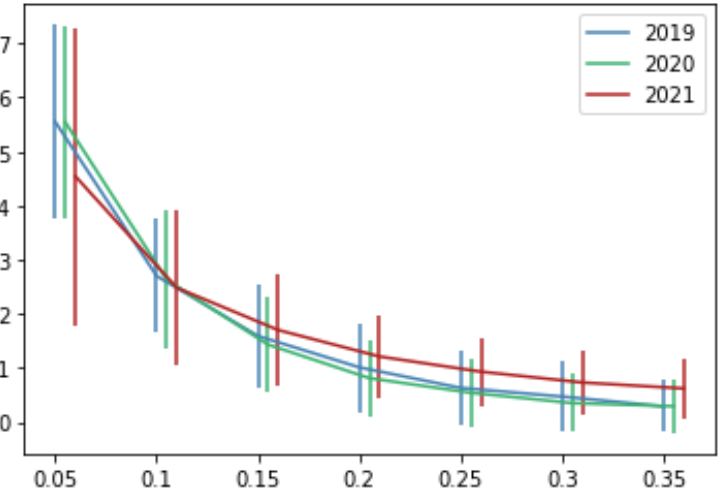
Figure 6. The average number of preferred restaurants ( y -axis) according to the value of the parameter pmin ( x -axis). Vertical lines represent the standard deviation.